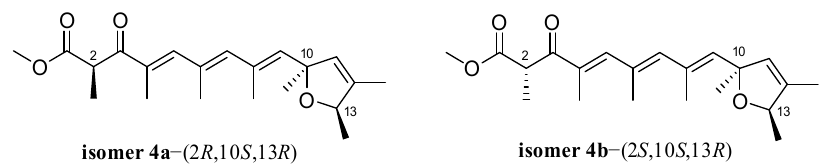
Figure 8. Two possible isomers of compound 4 for DP4+ probability analysis.